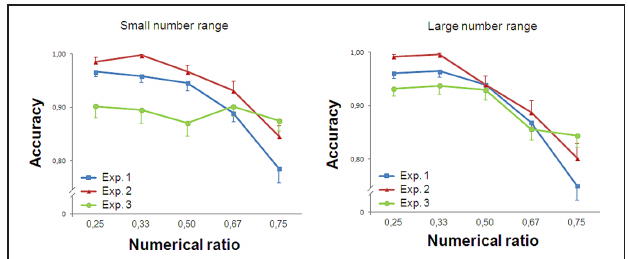
FIGURE 5 | Comparison of the three methods. When stimuli are simultaneously presented (Experiments 1 and 2), ratio dependence of the performance was observed also in the small number range. On the contrary, when stimuli were presented sequentially (Experiment 3), participants’ accuracy did not vary as a function of numerical ratio in the small number range.